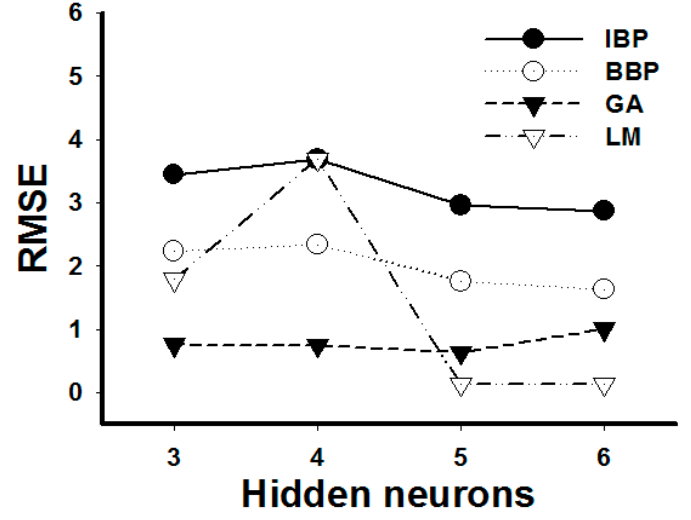
Figure 2. Learning curves of ANN model at different hidden neurons. The training set uses sigmoid transfer function in the hidden layer and output layer based on increment back propagation (IBP), batch back propagation (BBP), Levenberg-Marquardt algorithm (LM) or genetic algorithm (GA).